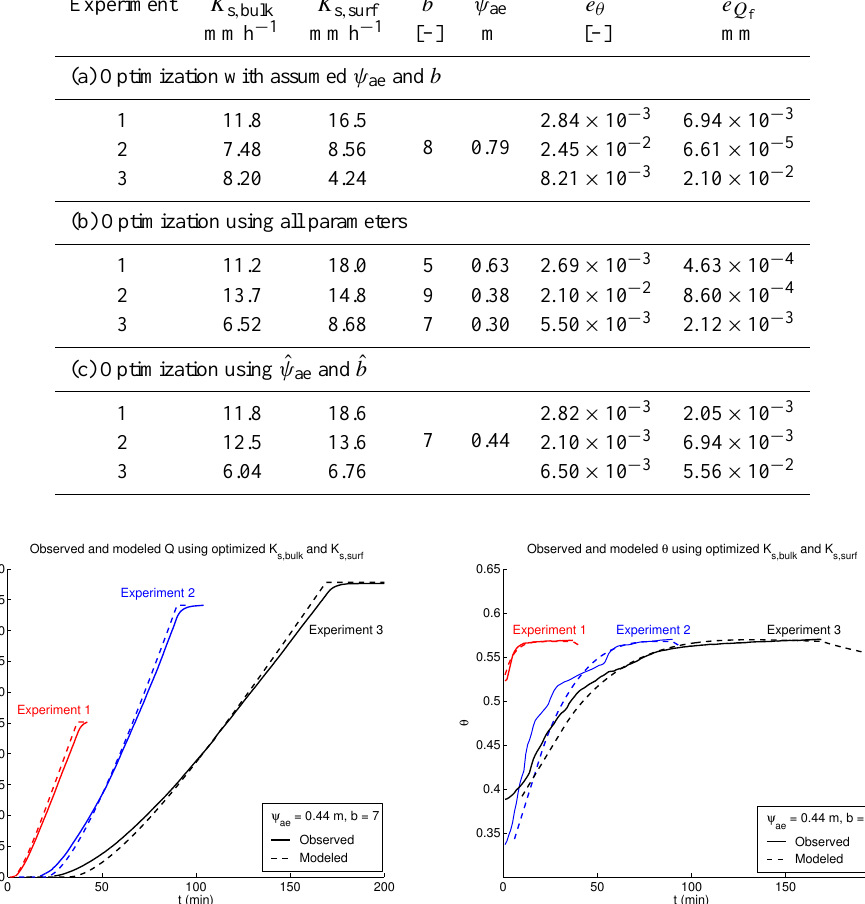
Figure 13. Observed and modeled Q and θ using ˆ b = 7 and ˆ ψ ae = 0 . 44m. Optimized hydraulic conductivity values are as follows: experiment 1: K s , surf = 18 . 6mmh − 1 , K s , bulk = 11 . 8mmh − 1 ; experiment 2: K s , surf = 13 . 6mmh − 1 , K s , bulk = 12 . 5mmh − 1 ; and experi- ment 3: K s , surf = 6 . 76mmh − 1 , K s , bulk = 6 . 04mmh − 1 .